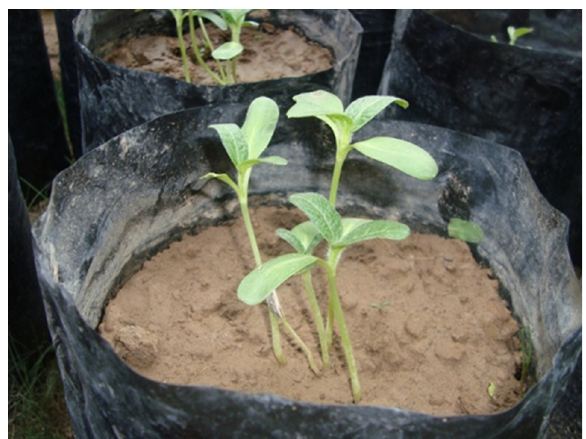
Fig. 1. Sunflower Plant Growth Treated in Pots